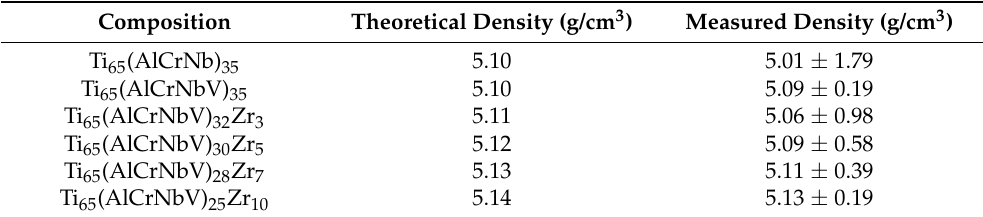
Table 2. The density of as-cast Ti 65 (AlCrNb) 35 , Ti 65 (AlCrNbV) 35 , and Ti 65 (AlCrNbV) 35-x Zr x (x = 3, 5, 7, 10) MEAs [27].